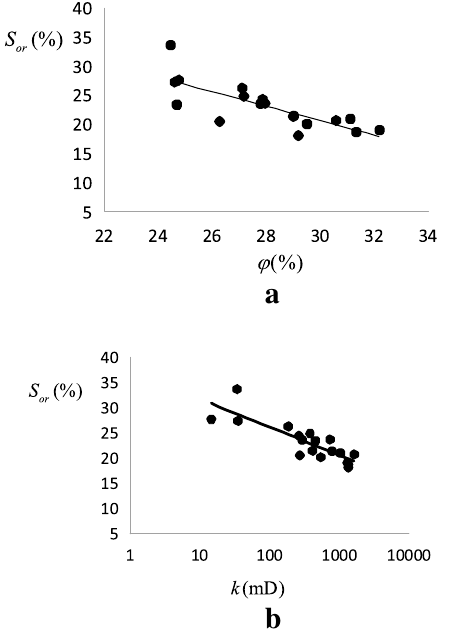
Fig. 5 a Correlation diagram of porosity ( 𝜙 ) and permeability ( k ), b correlation diagram of porosity ( 𝜙 ) and residual oil saturation ( S or